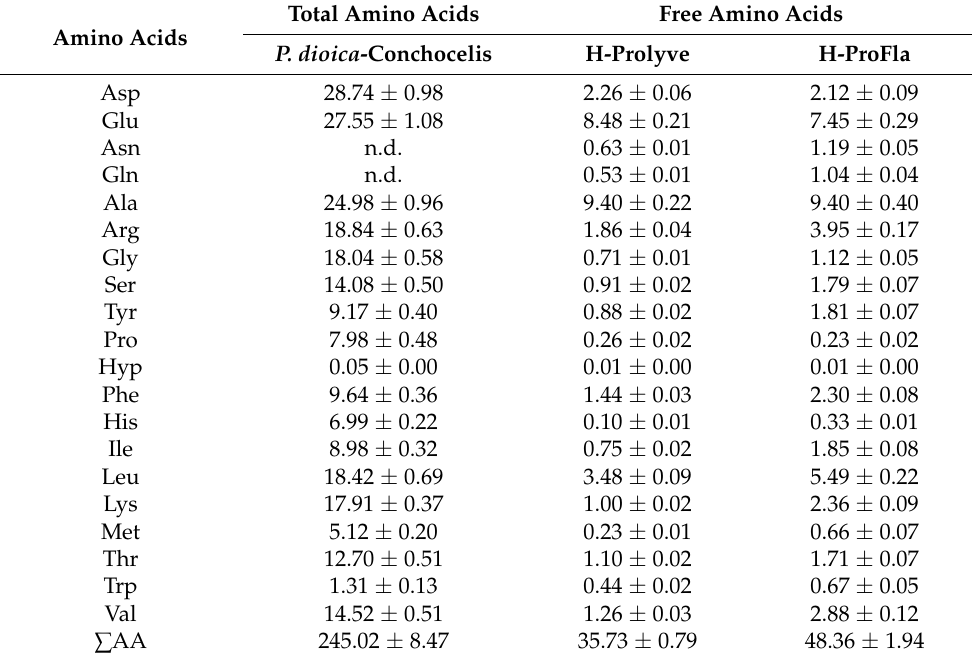
Results presented as mean ± SD of 3 independent extractions. AA: amino acids; n.d.: not detected. Amino acids are represented using the 3-letter